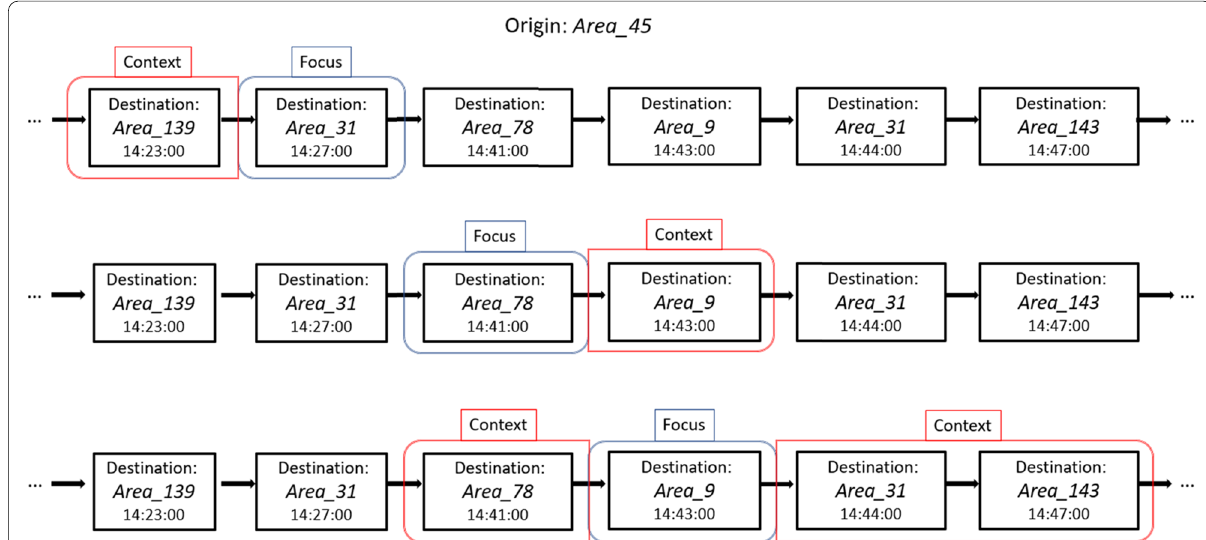
Fig. 1 Word2vec sliding window training process with a window size of five minutes in the past and five in the future